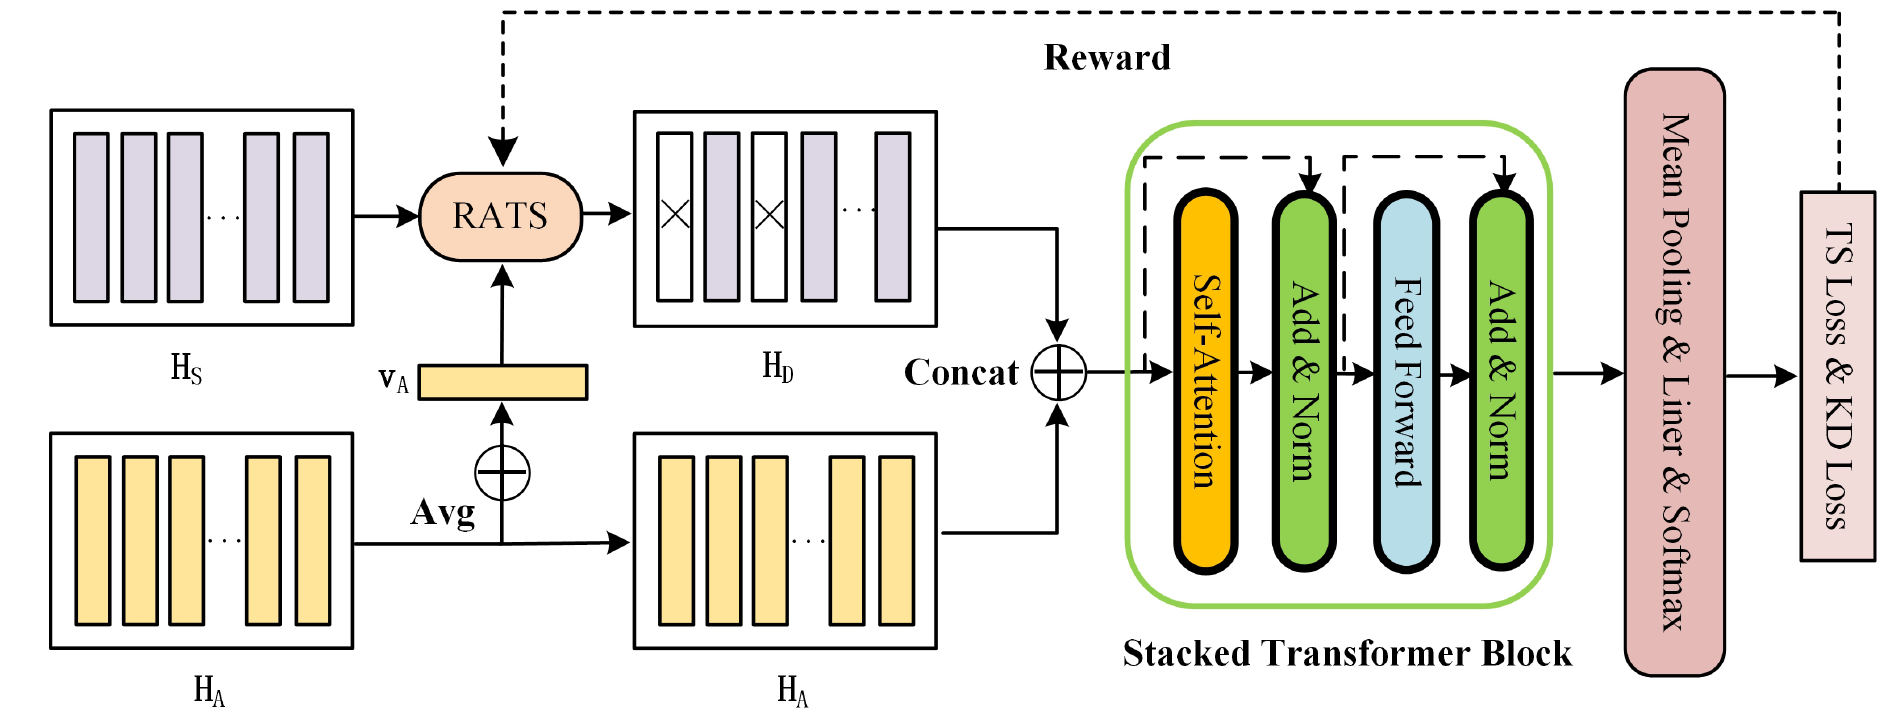
Figure 3. The framework of our proposed Reinforced Transformer with Cross-Lingual Distillation approach. TS Loss denotes task-specific loss and KD Loss denotes knowledge distillation